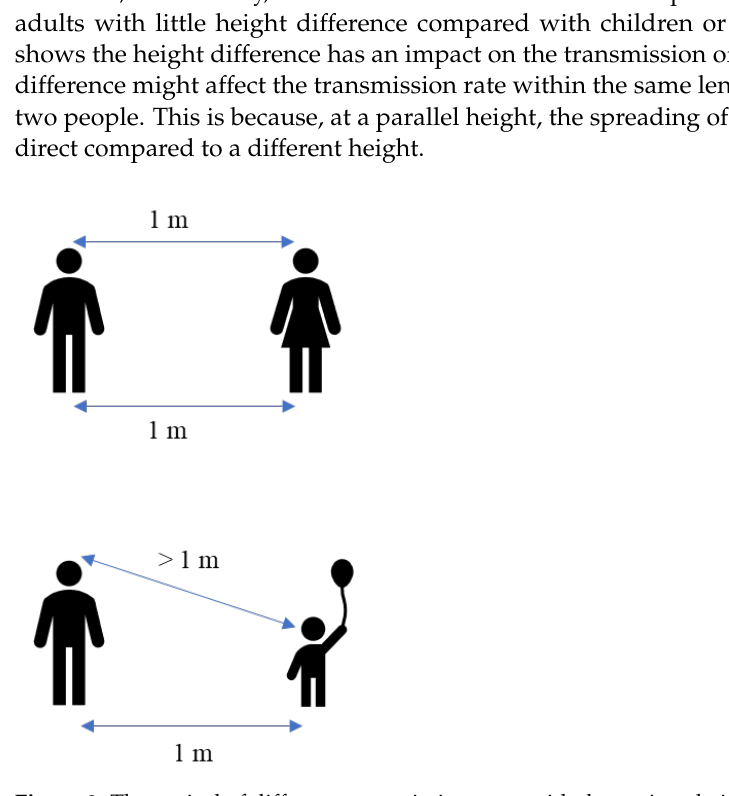
Figure 3. Theoretical of different transmission rates with the various height.